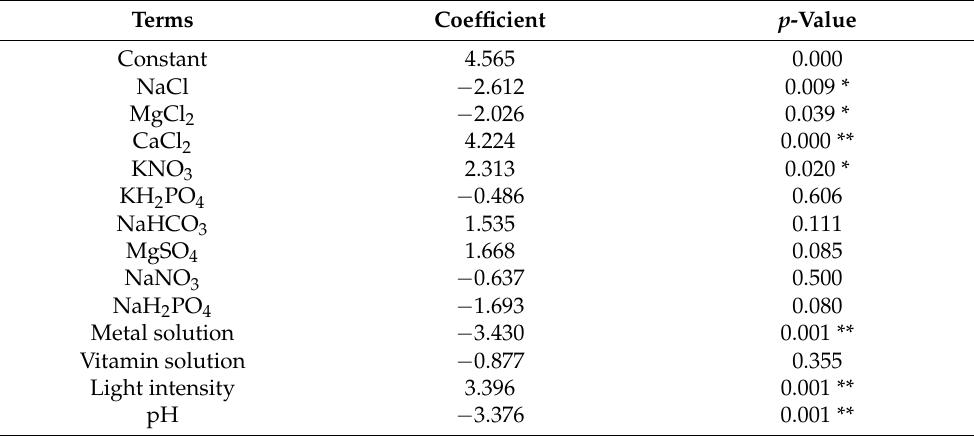
Table 5. Effect of different operational variables on PE production.